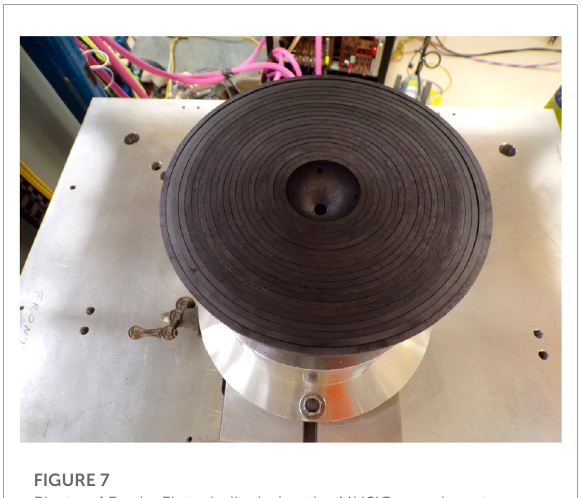
FIGURE 7 Photo of Rocky Flats shells during the MUSiC experiment.